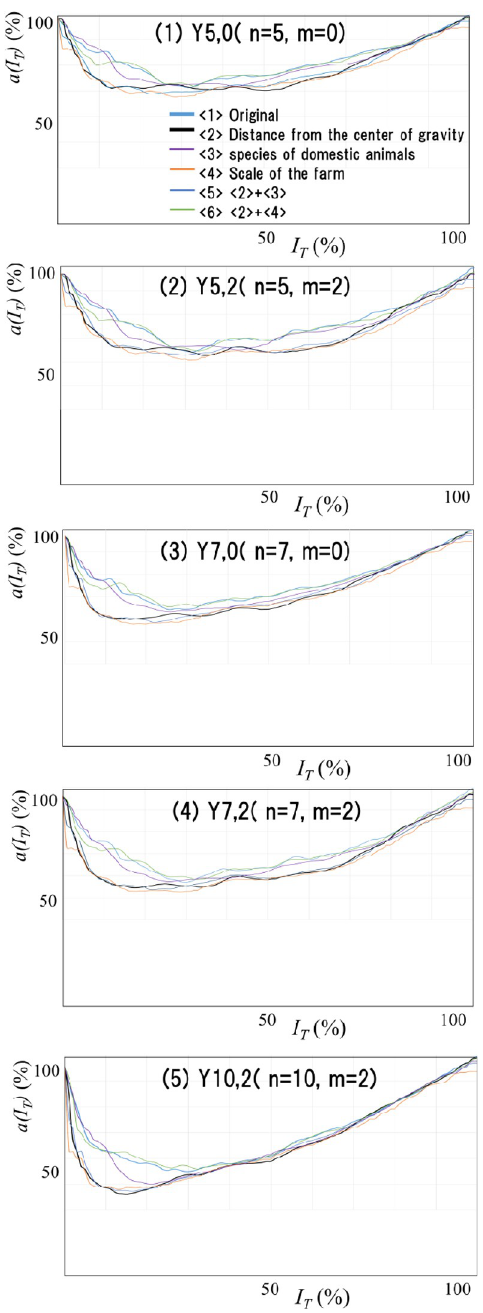
Fig 9. Performance evaluation graph for various FMD-VS. Fig 9 shows a part of the performance evaluation graph that is the basis of the evaluation results. The performance evaluation graphs of FMD-VS of 5 (patterns) x 6 (species) = 30 variations (by all the combination of no stratification ( < 1 > ) and five types of strata ( < 2 > to < 6 > ) and settings of 5 out of 8 patterns around infection day Y5,0, Y5,2, Y7,0, Y7,2, Y10,2) are created and shown in (1) to (5). The least value in each graph is the performance of each FMD-VS. The graph visually shows that the performance of FMV-DS constructed by stratification based on the distance from the center of gravity is high, and the performance is higher as the width of the period set around infection day is